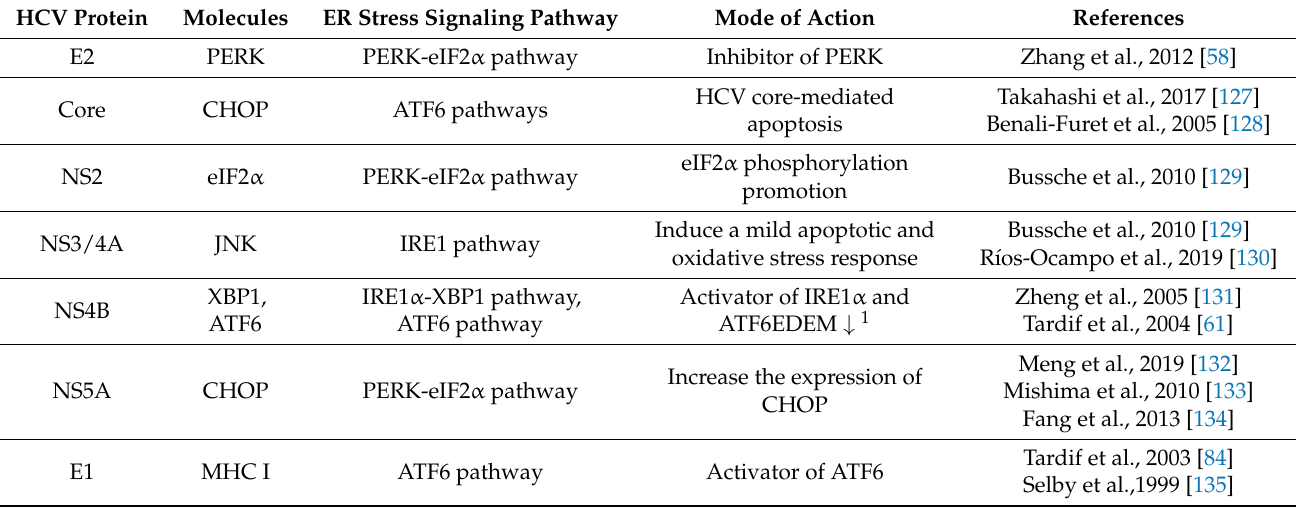
Table 2. Hepatitis C virus and associated ER stress